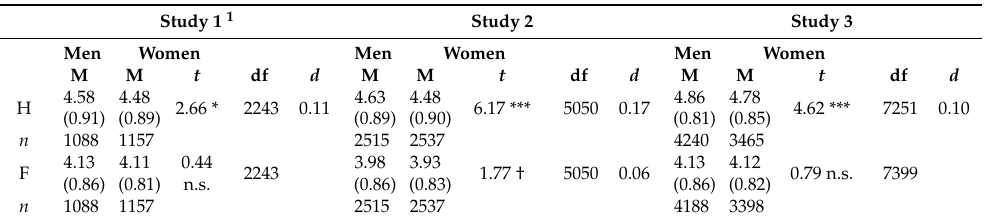
Table 6. Results of Independent Samples t -Tests of Hedgehogness and Foxiness Means of Men and Women.